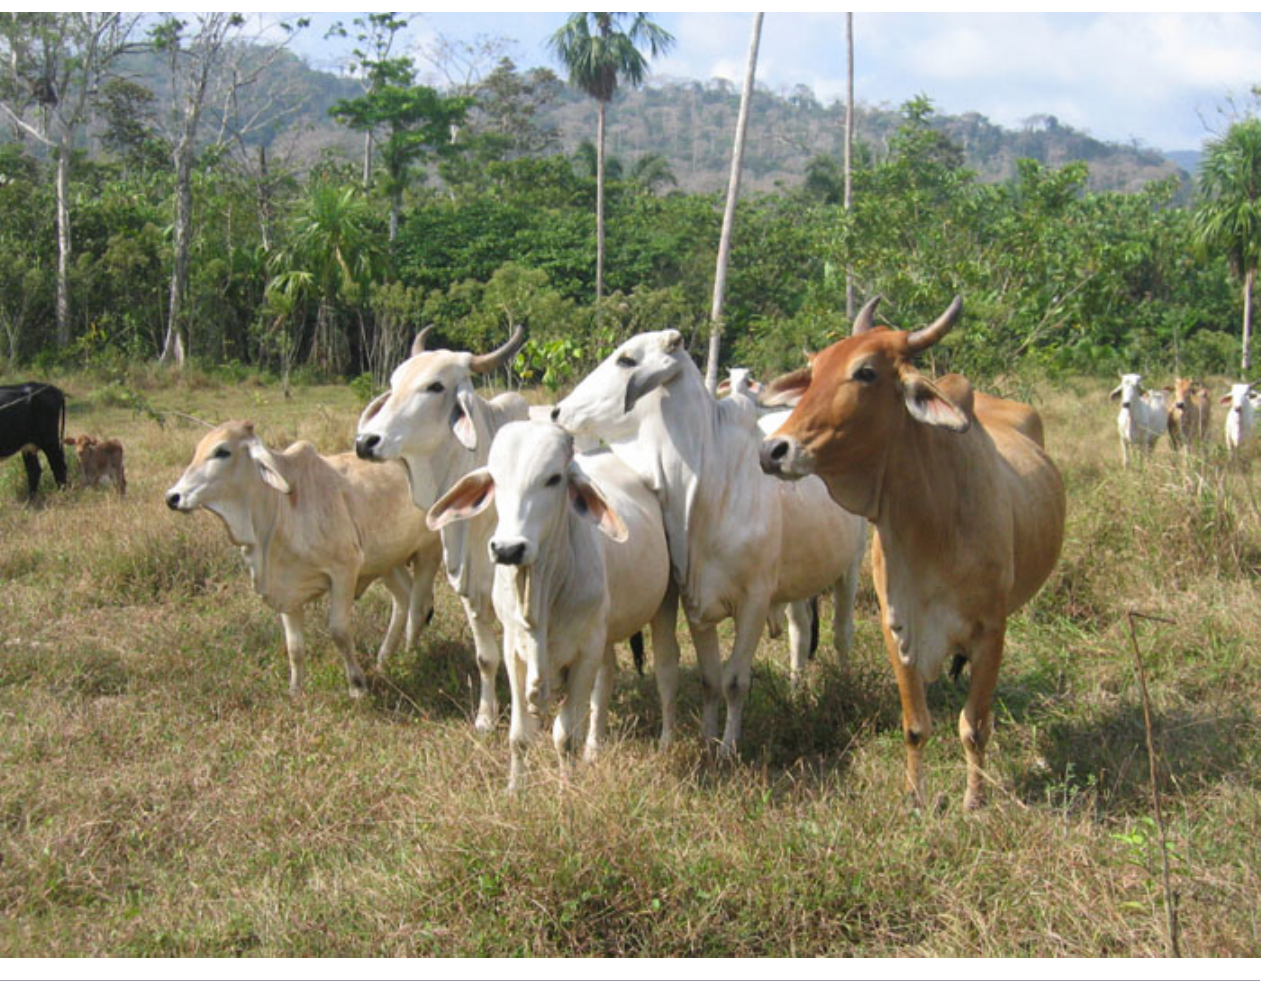
Fig. 1. Cattle ranching has become the fastest-growing livelihood in Ipetí and elsewhere in Central America. Cattle ranching provides much-needed income to local populations and acts as easy-to-cash savings in rural communities with no access to credit. It is also a leading cause of deforestation in the area and contributes to global